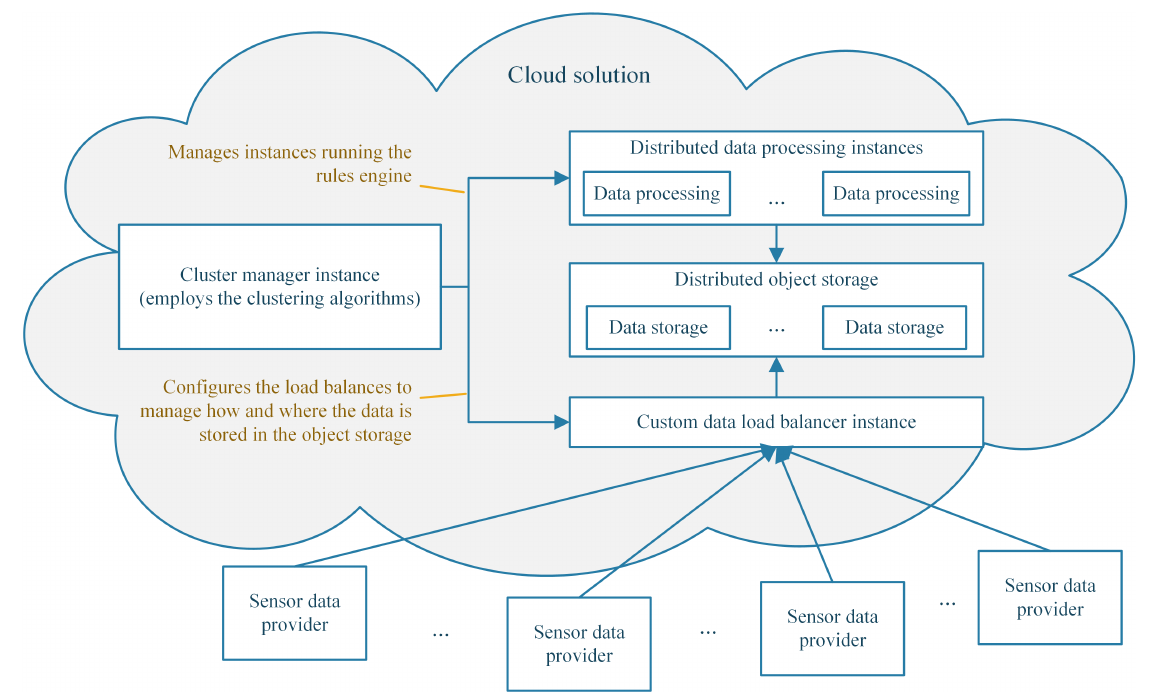
Figure 5. Proposed cloud solution